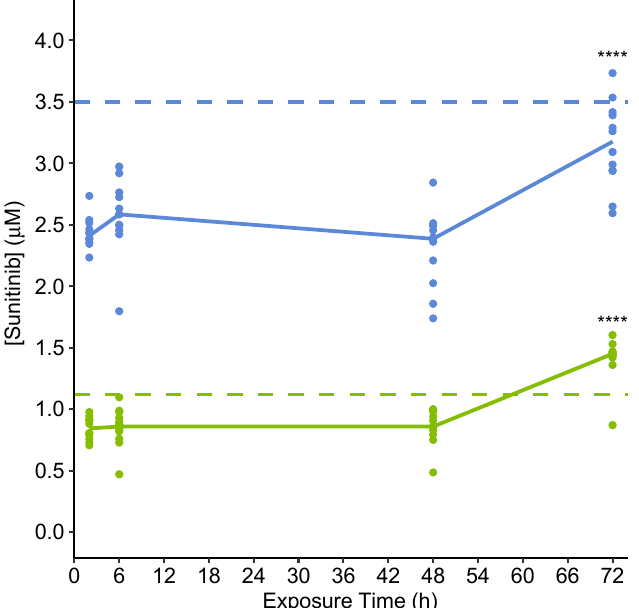
Figure 3. Absolute sunitinib concentrations in spent media of pooled microtissues collected at 2, 6, 48 and 72 h after initial exposure as calculated from measured peak areas using an external calibration curve. Solid lines show the median extracellular sunitinib concentration at each time point for low (green) and high (blue) exposures separately. Nominal low and high exposure concentrations are displayed as a dashed line, green and blue, respectively. **** p < 0.0001, for comparison of concentrations at 48 h vs. 72 h, per concentration (two-sided t -test). All other comparisons of concentrations at consecutive time points (2 vs. 6 h, 6 vs. 48 h) were not significant ( p > 0.05).